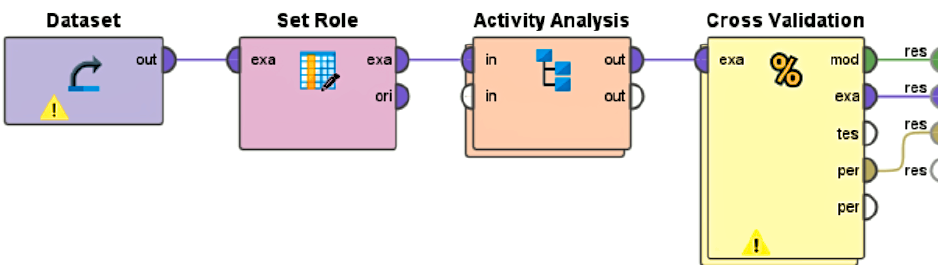
Figure 1. The process developed in RapidMiner to develop and implement the proposed framework for personalized indoor localization.